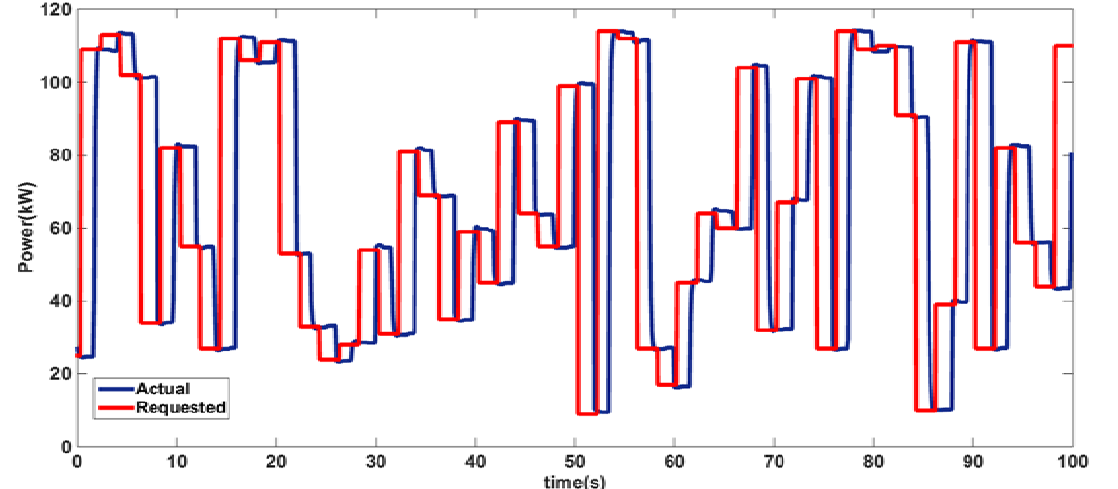
Figure 15. Electrolyzer following a practical utility demand response program